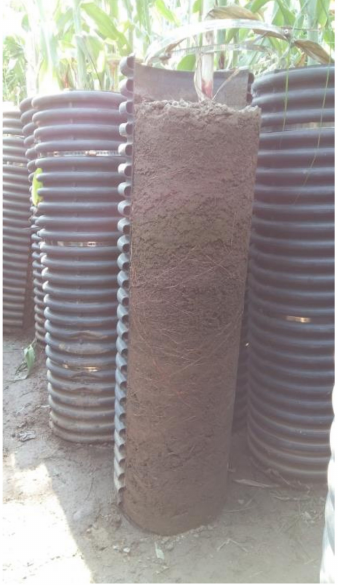
Figure 2. The cultivation of soil columns used in this